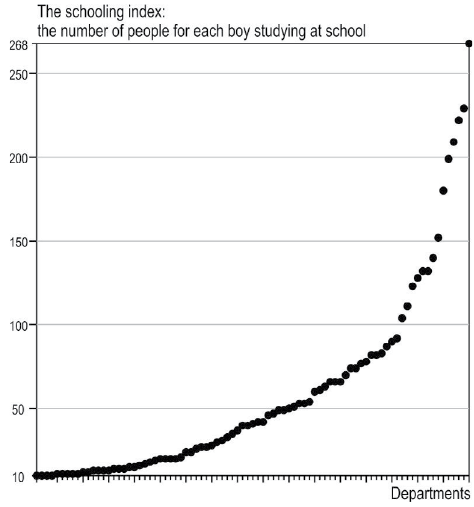
Fig. 2. Graphic array of the statistical